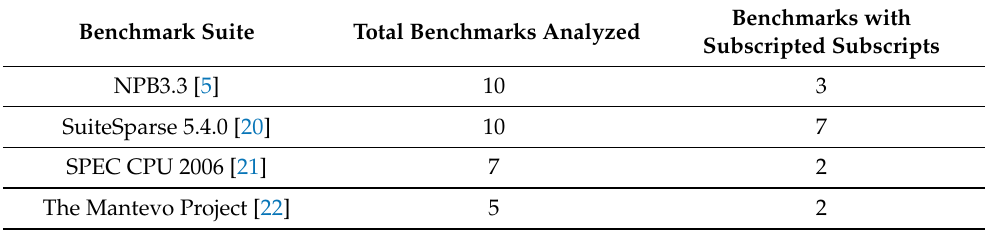
Table 1. Benchmarks codes analyzed for the presence of subscripted